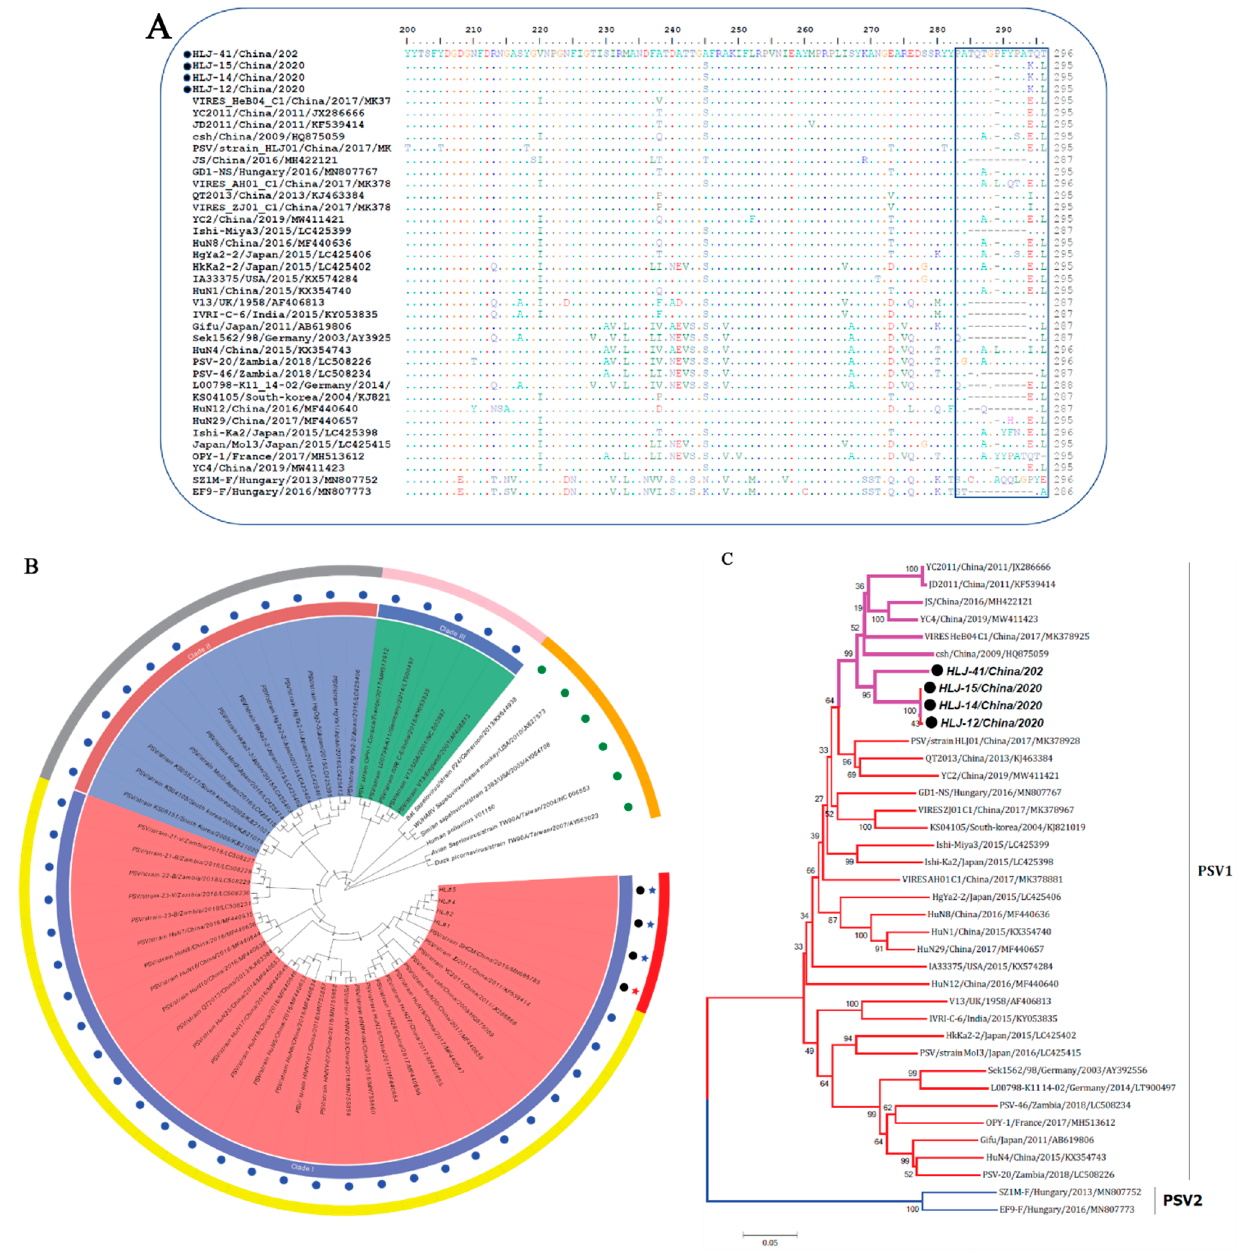
Figure 2. Sequence analysis of the isolated PSV strains. ( A ) Alignment of 3 ′ -partial amino acid sequences of VP1 of PSV strains. Sequences in boxes showed the hypervariable region in the C- terminus of VP1. The strains identified in the present study were indicated by black dots; (-), missing amino acids. ( B & C ) Phylogenetic analysis of PSV based on the complete nucleotide sequence and VP1 gene respectively. The trees were generated by using MEGA v.6.0 with the neighbor-joining method with the Kimura 2-parameter with 1000 bootstrap replication. The black circle indicates PSV isolated in this study. The scale bars represent the number of substitutions per site.